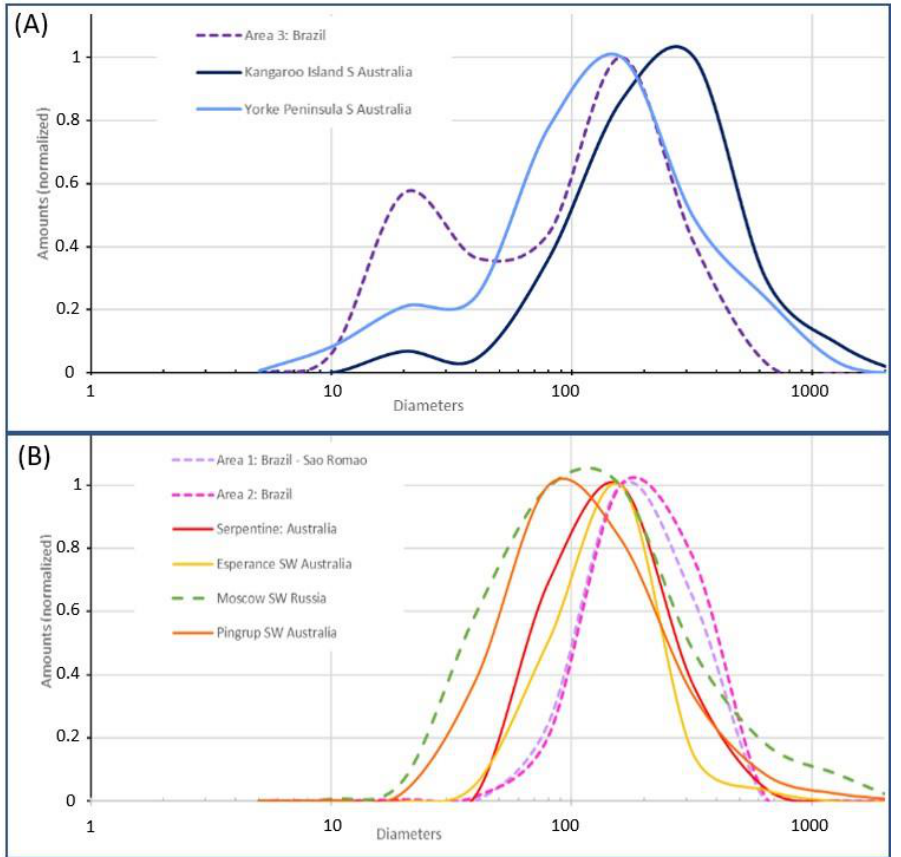
Figure 11. Normalized distribution of the diameters deduced from the raw data Figures 4, 8 and 9. ( A ) The ones which present two maxima, zone 3 in Brazil, and the Adelaide area. ( B ) The ones with a simple maximum: Russia and the other areas in Brazil and Australia. The more probable values are between 150 m and 200 m except for Kangaroo Island where it is larger.